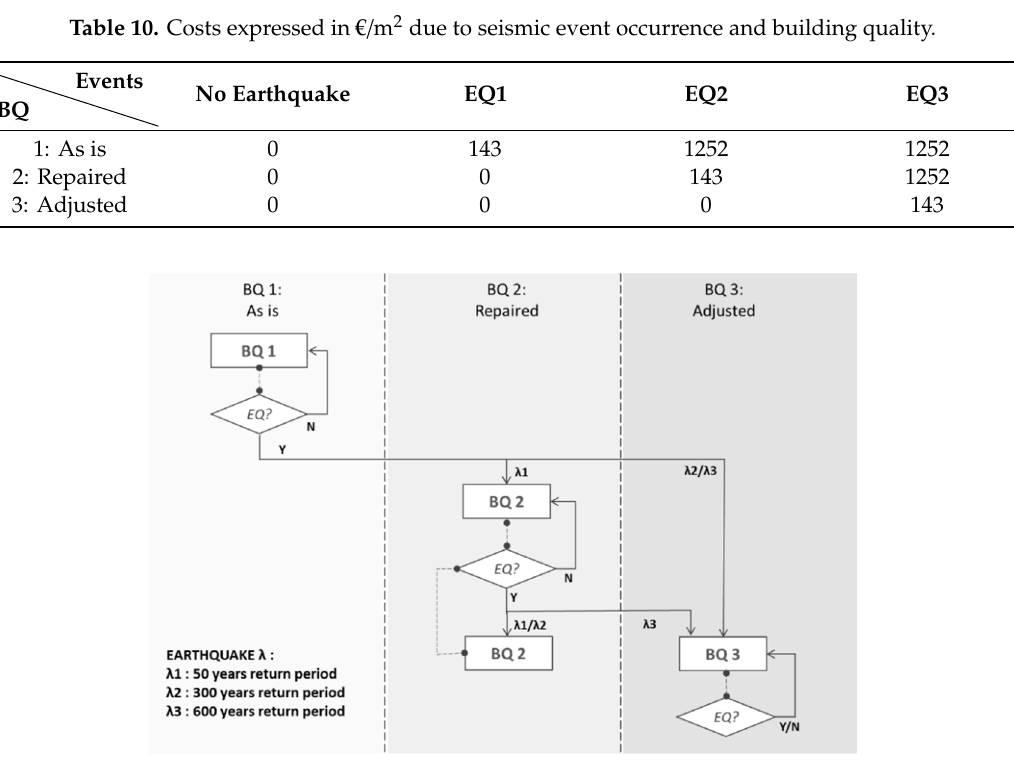
Table 11. Probabilistic LCA–LCC results (10,000 runs MC simulation).